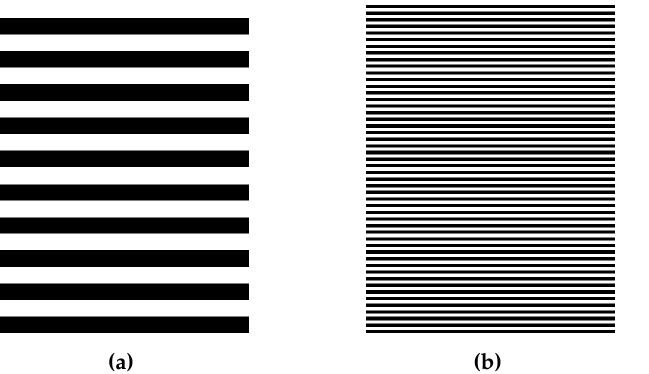
Figure 11. Simulated binary image. ( a ): α = 10; f SW = 300 Hz; ( b ): α = 50; f SW = 1500 Hz.